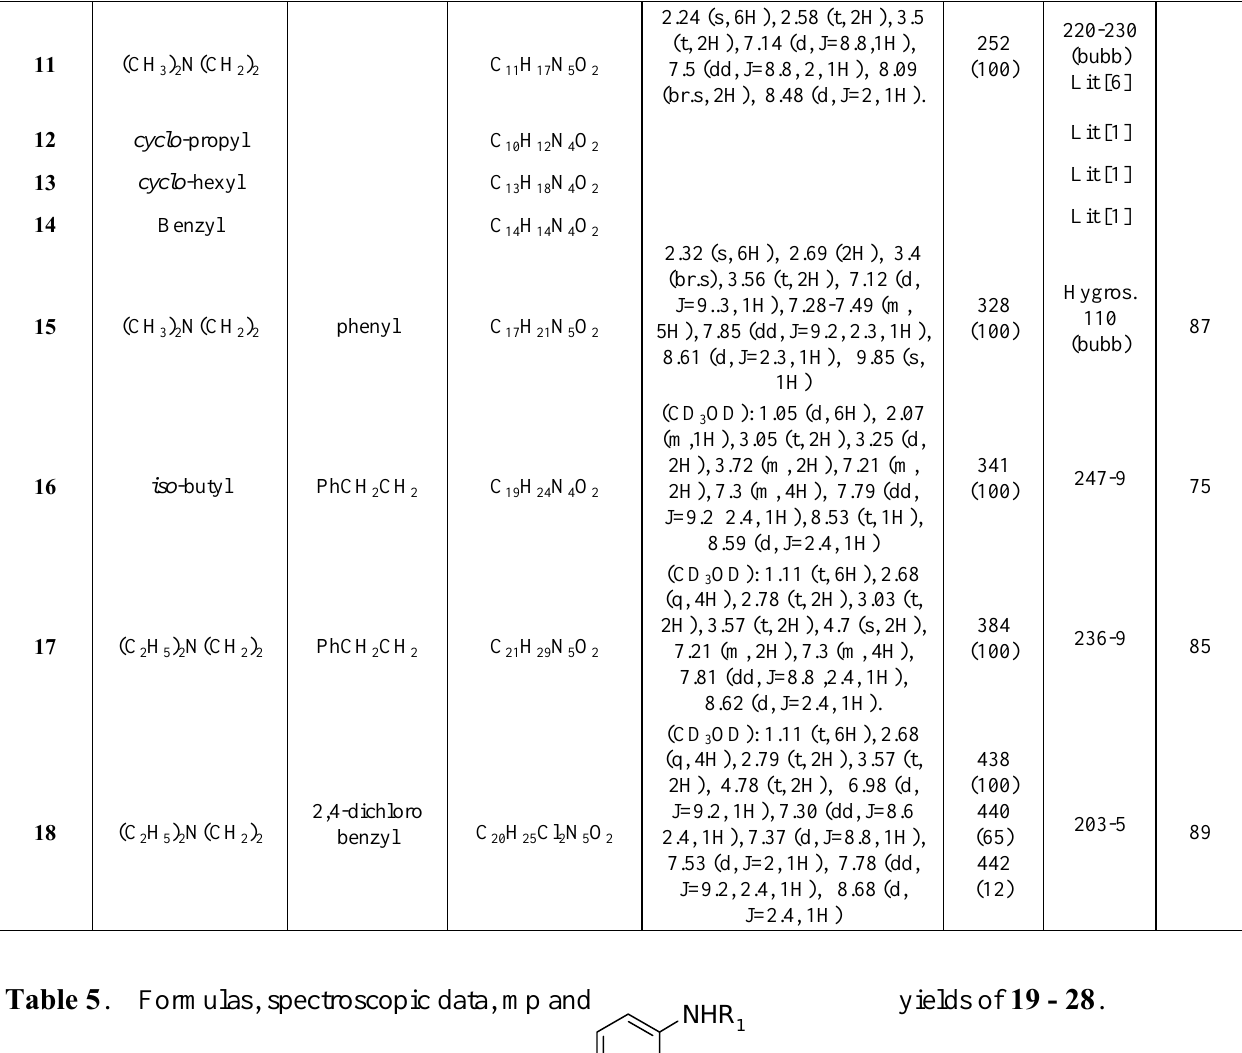
Formulas, spectroscopic data, mp and yields of 19 - 28